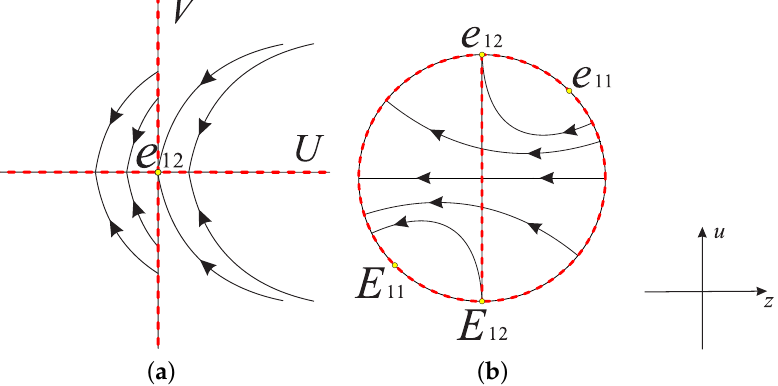
Figure 27. ( a ) The local phase portrait at the infinite equilibrium point e 12 . ( b ) The global phase portrait of system (32). E 11 and E 12 are the diametrally opposite equilibrium points of e 11 and e 12 in the Poincaré disc,